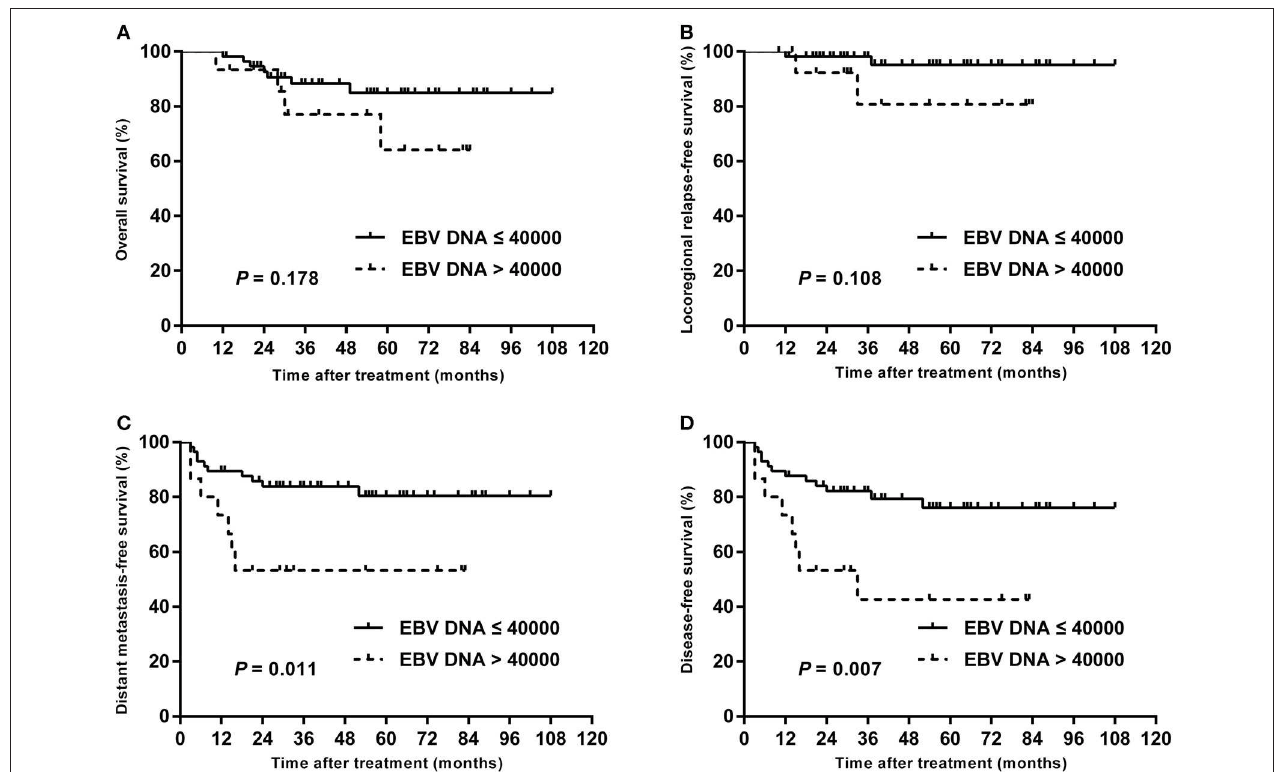
FIGURE 4 | Kaplan–Meier estimate of the OS (A) , LRRFS (B) , DMFS (C) , and DFS (D) of T4 children and adolescent NPC patients according to pretreatment EBV DNA